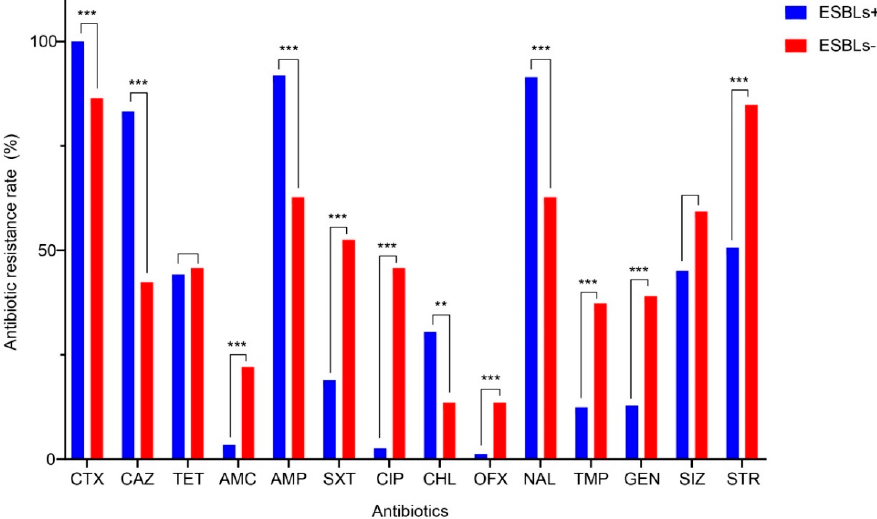
Figure 3. Comparison of multidrug resistance rates between ESBL-producing (ESBLs + , n = 233) and